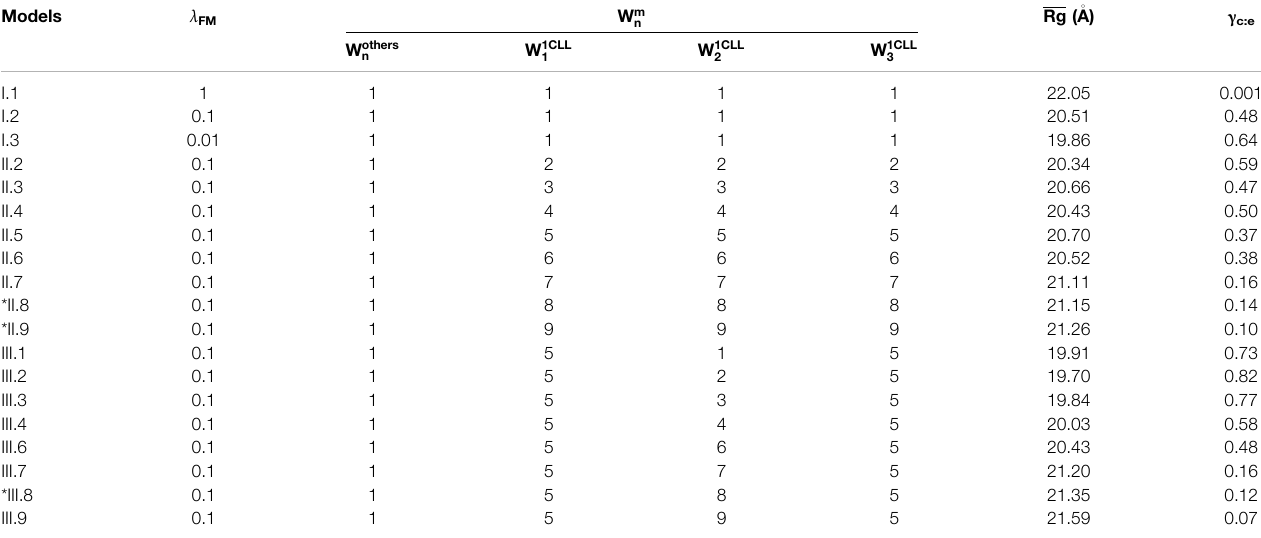
TABLE 2 | Summary of Ca 2+ -CaM models with different values of the global and local memory weight and the average Rg ( Rg ) and the ratio between the collapsed and extended states ( γ c:e ) from the umbrella sampling simulations. The models that best reproduce experimental results from our simulations are marked with *. The experimental measured Rg (cid:1) 20.0 ∼ 22.5 (cid:1) A and γ c:e ∼ 0.11. Models